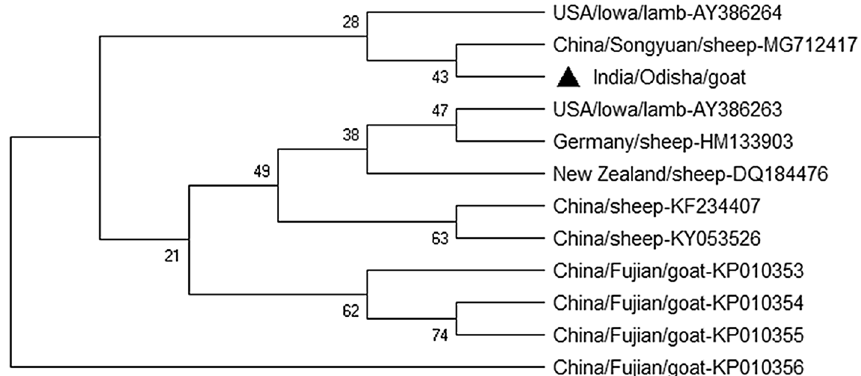
Figure 7. The concatenated phylogenetic tree was constructed using the bootstrap consensus tree building method of neighbor-joining with bootstrap value 500 using MEGA 5. Black triangle represents the ORFV isolates of present investigation showing its relationship with eleven global